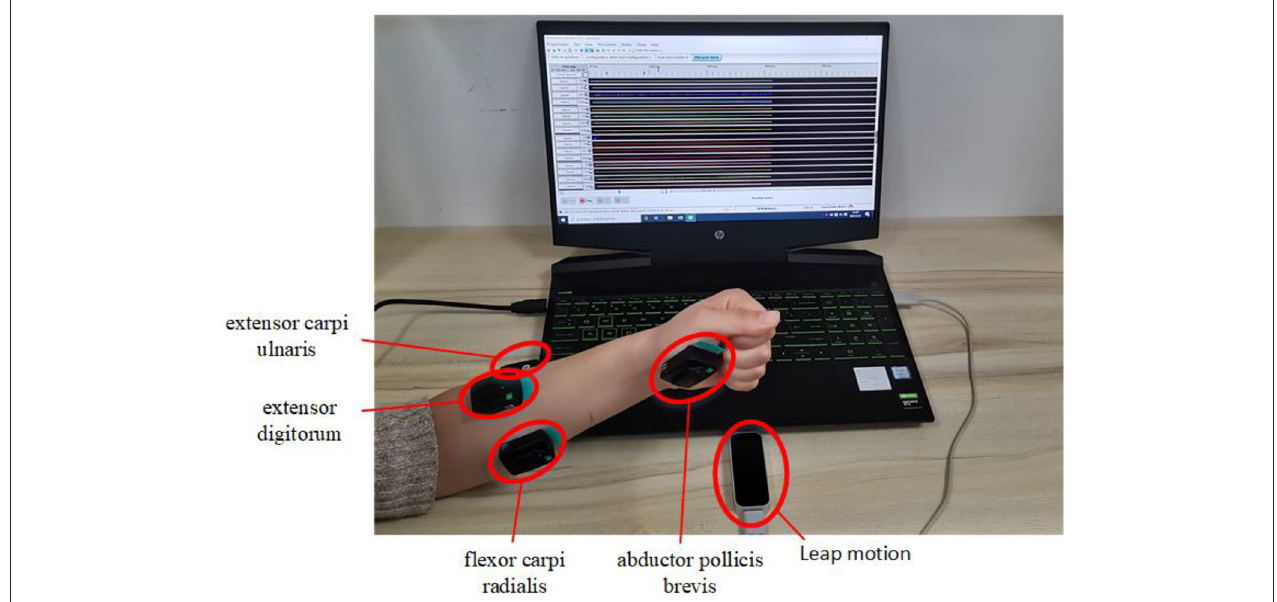
FIGURE 2 | Demonstration of the experimental setup of EMG and kinematic sensors. EMG signals are recorded from muscles of abductor pollicis brevis, flexor carpi radialis, extensor digitorum, and extensor carpi ulnaris of the left hand and kinematics data are recorded from Leap motion sensor.